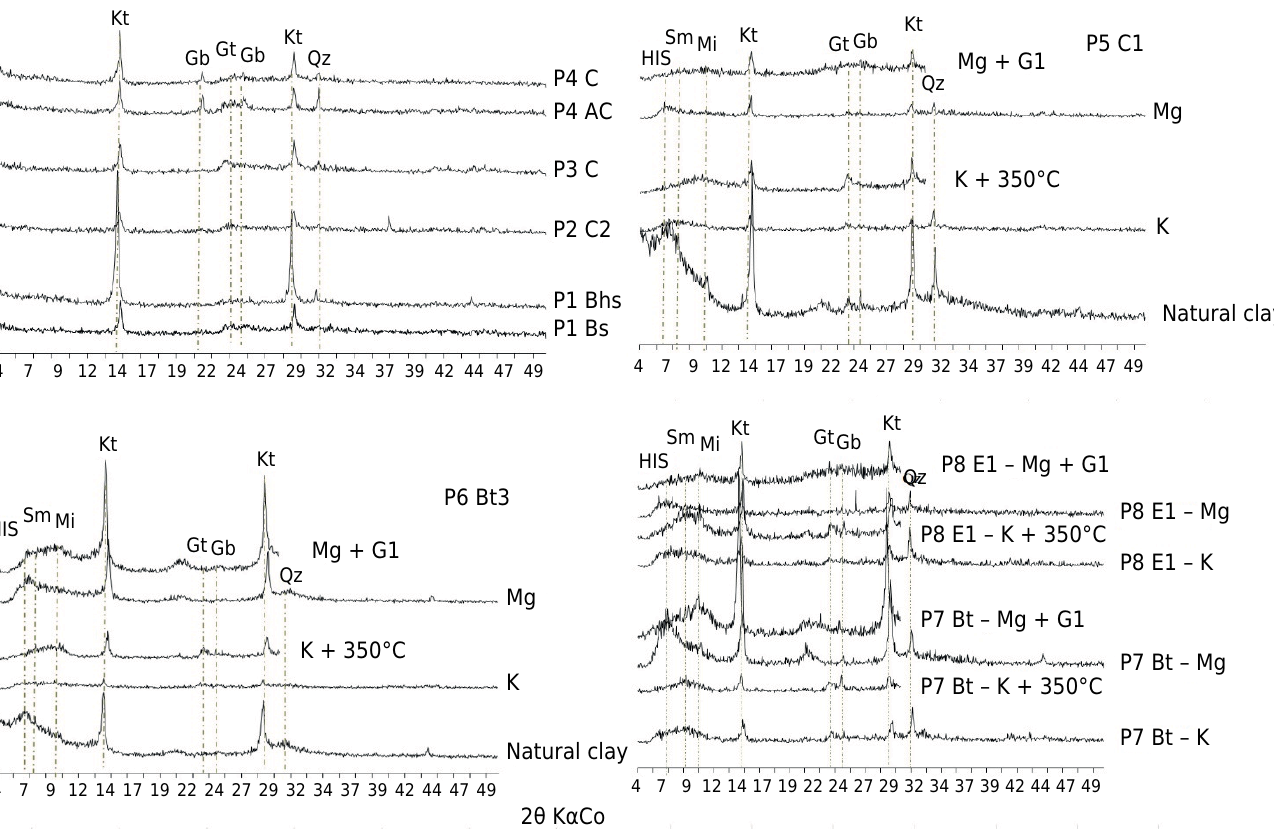
Figure 3. X-ray diffraction of natural clay fractions (P1 to P4) and treated clay samples (P5 to P8). Kt: kaolinite; Gb: gibbsite; Qz: quartz; Gt: goethite; Sm: smectite; Mi: mica; HIS: hydroxyl-Al interlayered